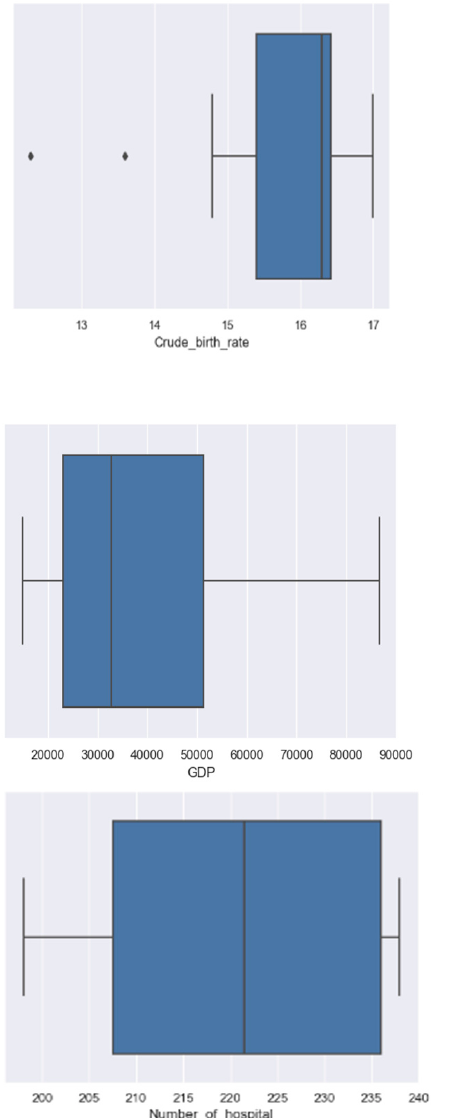
Figure 3. Boxplots representing the variables of interest, inputs, and outputs used in the development of the models.